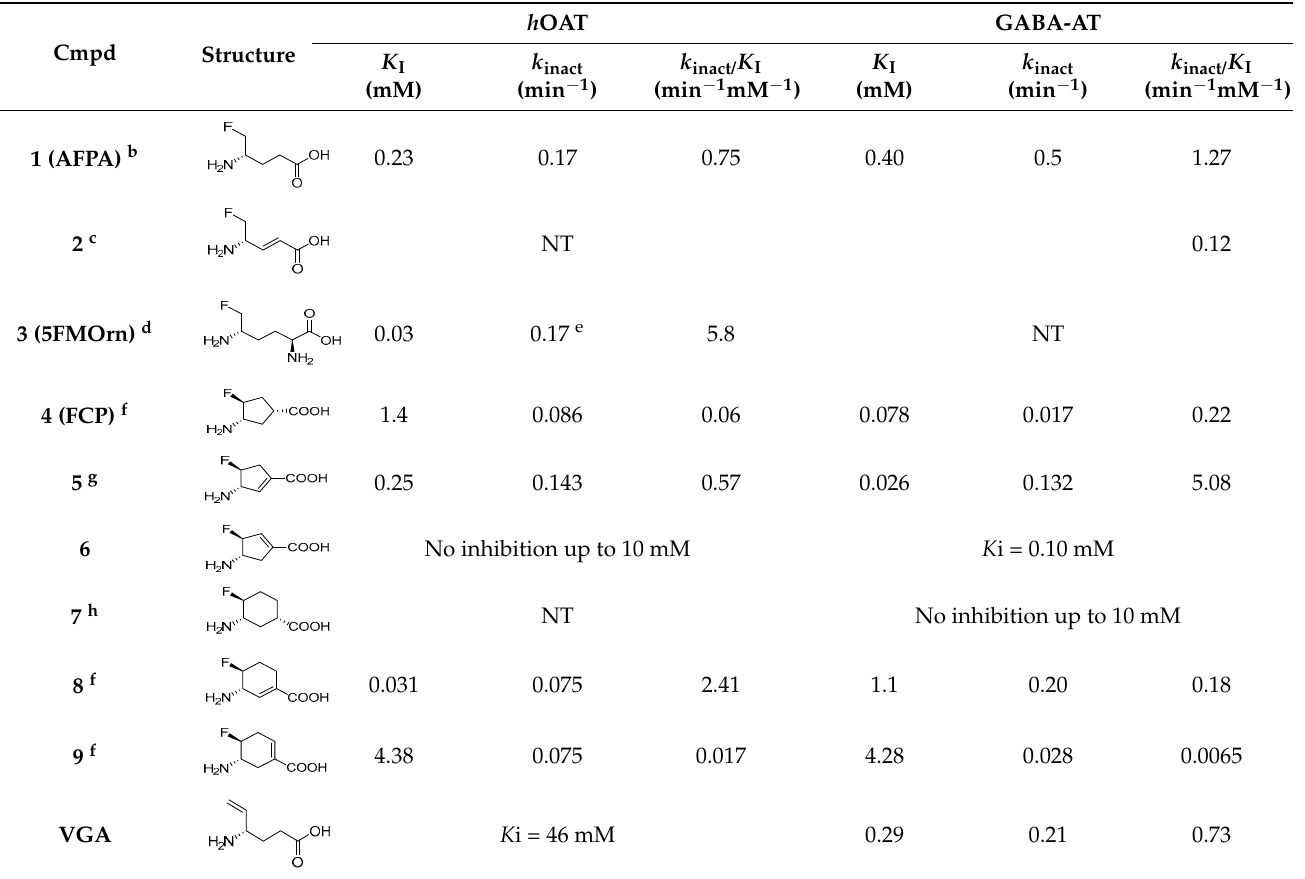
Table 1. Kinetic constants for the inhibition of h OAT and GABA-AT by 1 – 9 and ( S )-vigabatrin a.